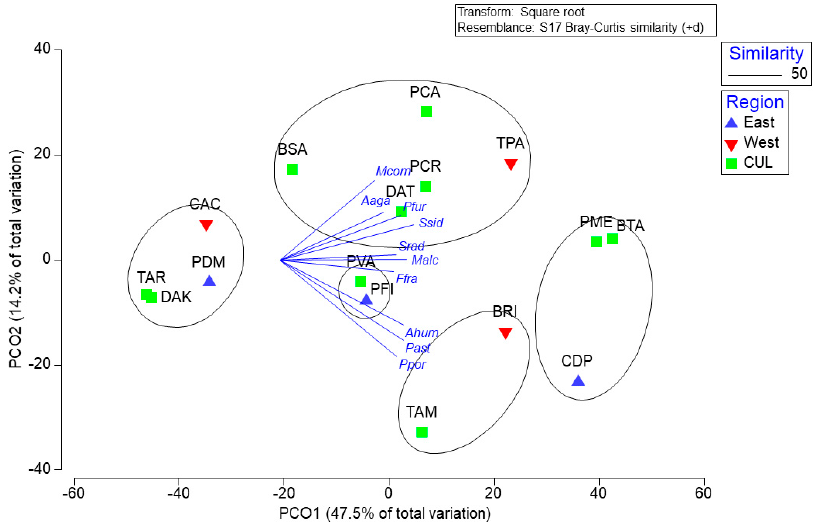
Figure 6. PCO analysis based on the √ -transformed coral recruit density (#/m 2 ) by region and by location. This solution explains 61.7% of the observed spatial variation. Refer to the Methodology for the description of acronyms.